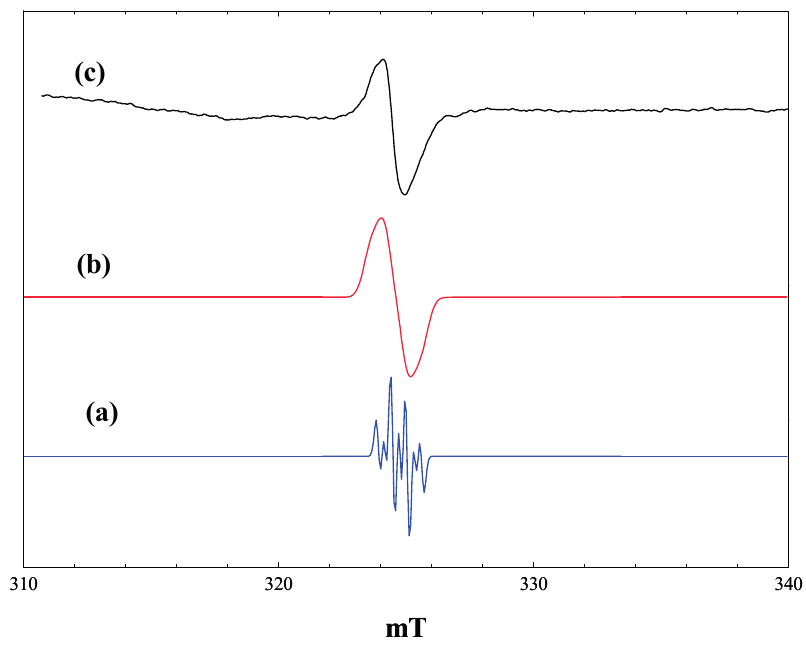
Figure 5. Comparison of simulated and observed spectra of the maleimide radical anion. (a), Simulated with a(N) = 0.262 mT, a(2H) = 0.580 mT, a(NH) = 0.031 mT, Gaussian line width of 0.2 mT; (b), Gaussian line width of 0.6 mT; (c), observed spectrum following broad-band irradiation at 80